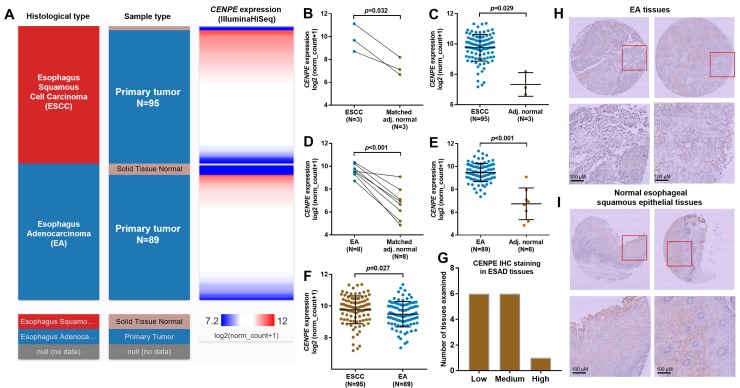
CENPE was significantly upregulated in both ESCC and EA tissues compared with their respective adjacent normal tissues.A. A heatmap showing the expression of CENPE in both ESCC and EA tissues and their respective adjacent normal tissues. B-F. Comparison of CENPE expression between ESCC/EA and the matched adjacent normal tissues (B and D), between all ESCC/EA tissues and the adjacent normal tissues (C and E) and between ESCC and EA tissues (F). G. CENPE IHC staining score summary in the 13 cases of EA tissues examined. H-I. Representative images of CENPE staining in EA (H) and normal esophageal squamous epithelial tissues (I).